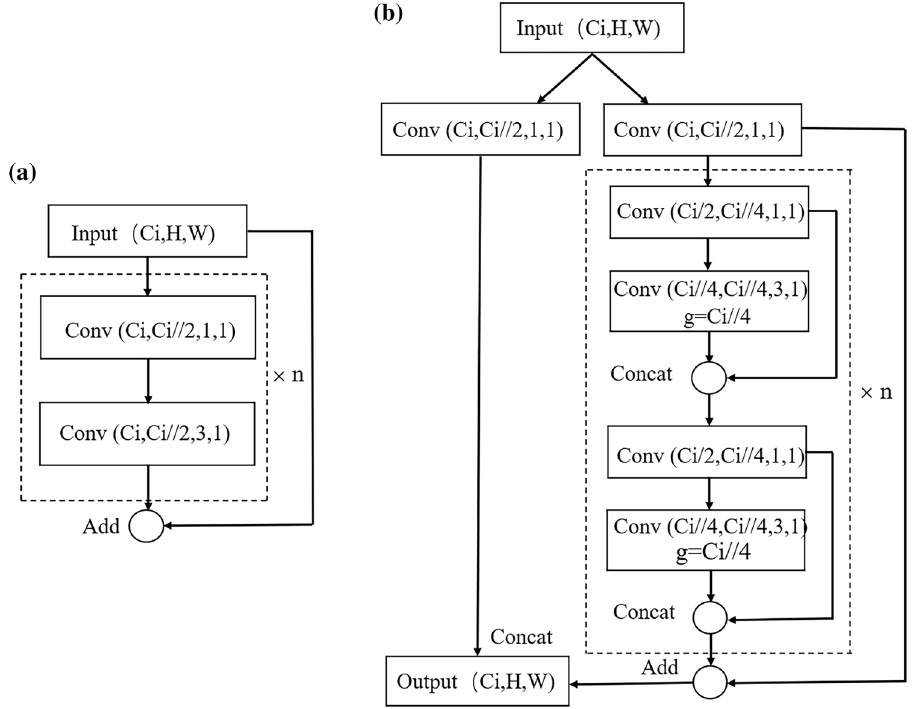
Figure 6. Network of ResNet and CSP-Ghost-ResNet. ( a ) represents the network of ResNet, and ( b ) represents the network of CSP-Ghost-ResNet.